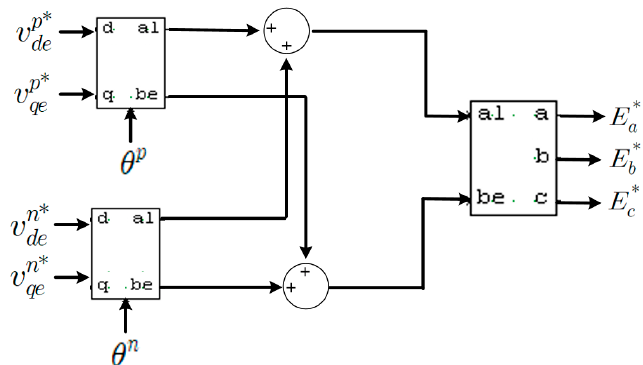
Figure 6. 3-phase conversion of stationary reference frame.